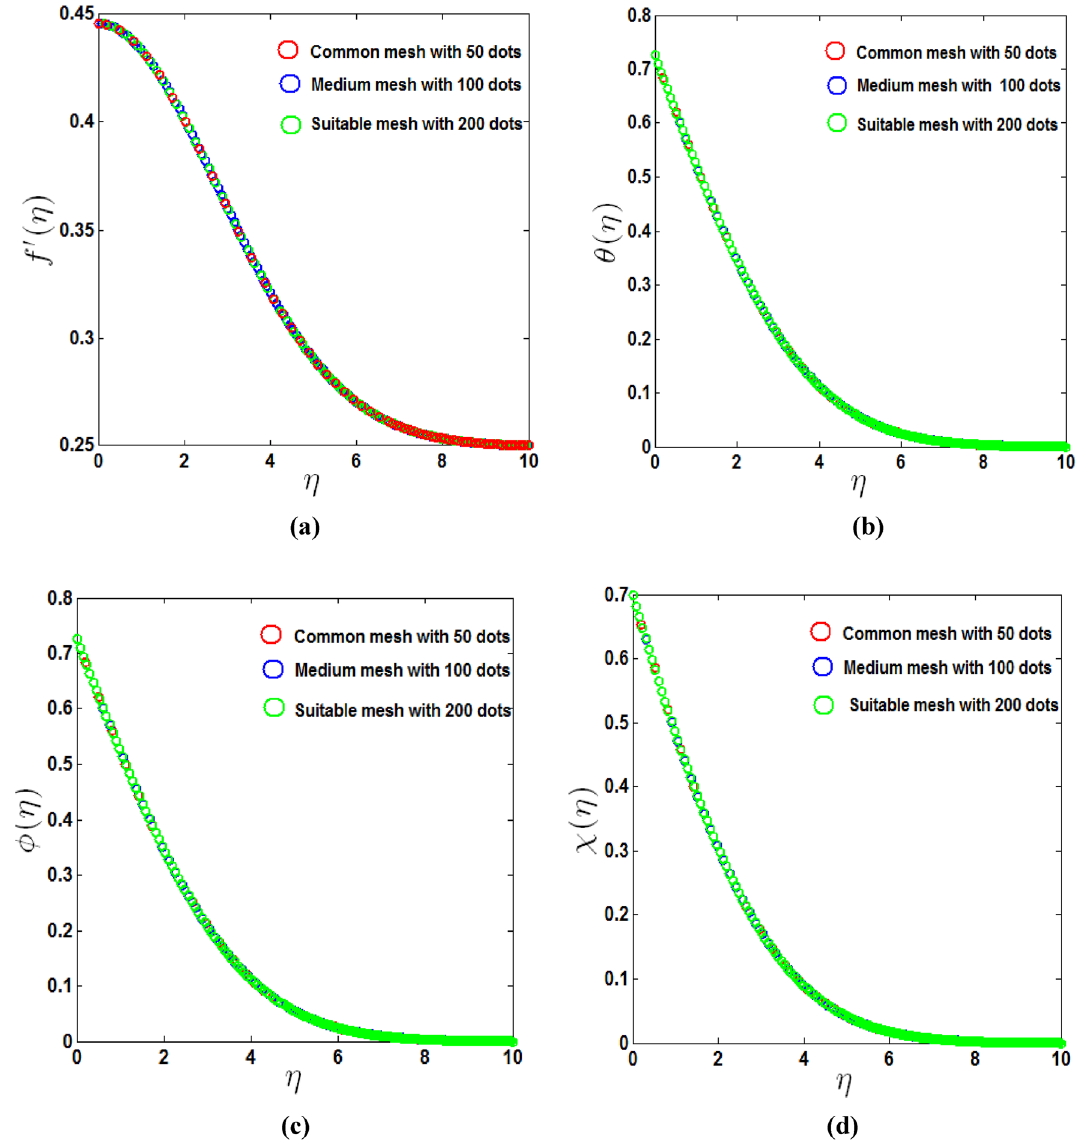
Figure 8. Grid Independence test ( a ) velocity profile f ′ (η) , ( b ) temperature profile θ(η) , ( c ) concentration profile φ(η) , ( d ) microorganism profile χ(η)